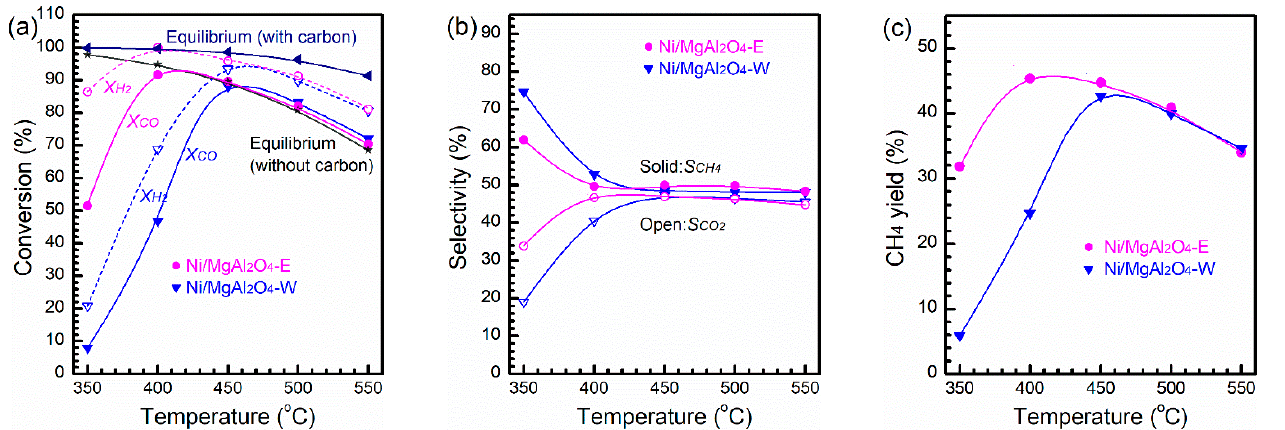
Figure 3. ( a ) Conversion, ( b ) selectivity and ( c ) CH 4 yield for dry methanation reaction over Ni/MgAl 2 O 4 -W and Ni/MgAl 2 O 4 -E as a function of reaction temperature at GHSV of 10,000 mL h − 1 g cat. − 1 .